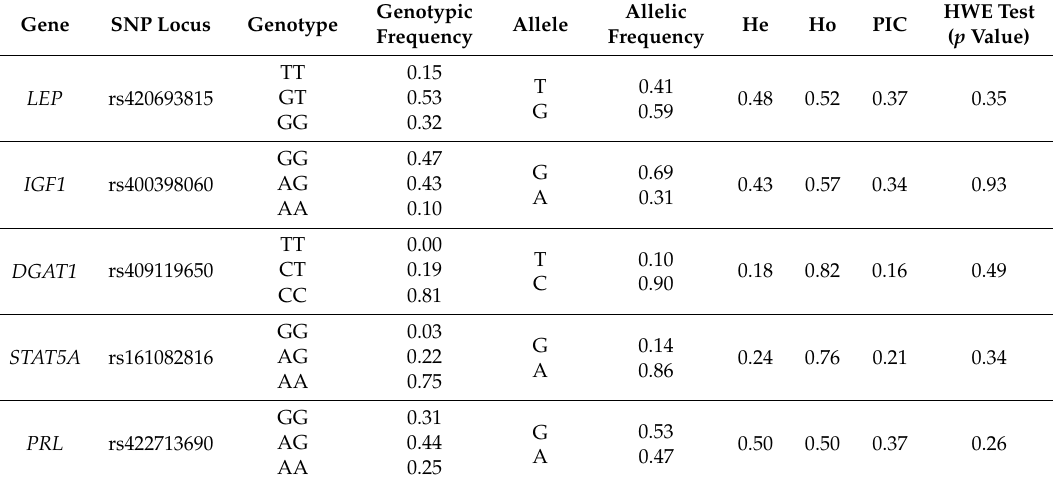
Table 4. Genetic parameters of the single nucleotide polymorphisms (SNP) markers of the studied candidate genes in the Barki ewe